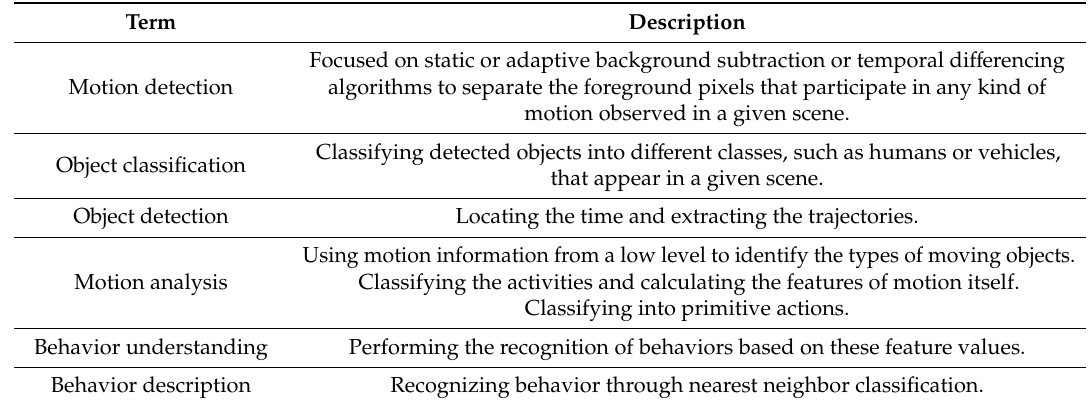
Table 2. Video surveillance aspects in Antonakki’s model